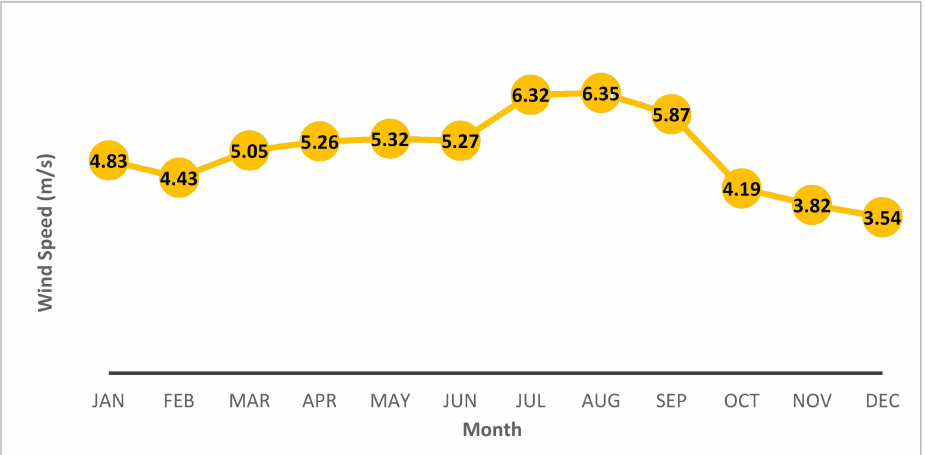
Figure 5. Wind speed variation per